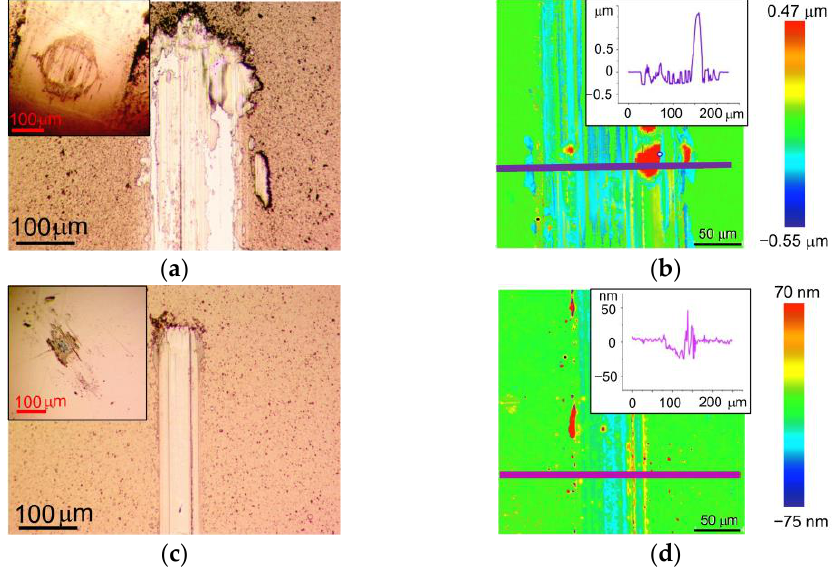
Figure 9. Wear of the ( a , b ) WSe x /NP-W and ( c , d ) WSe x S y /NP-W_3.6 coatings after tribotest in N 2 -enriched environment at a load of 1 N: inserts in ( a , c ) show the wear scars of counter bodies (balls), and the depth profile of the wear tracks are shown in the inserts in ( b , d ).